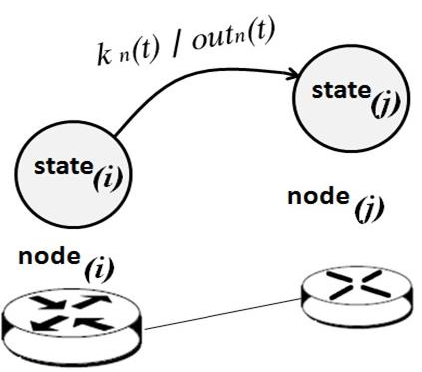
Figure 2. Network nodes using as model the states